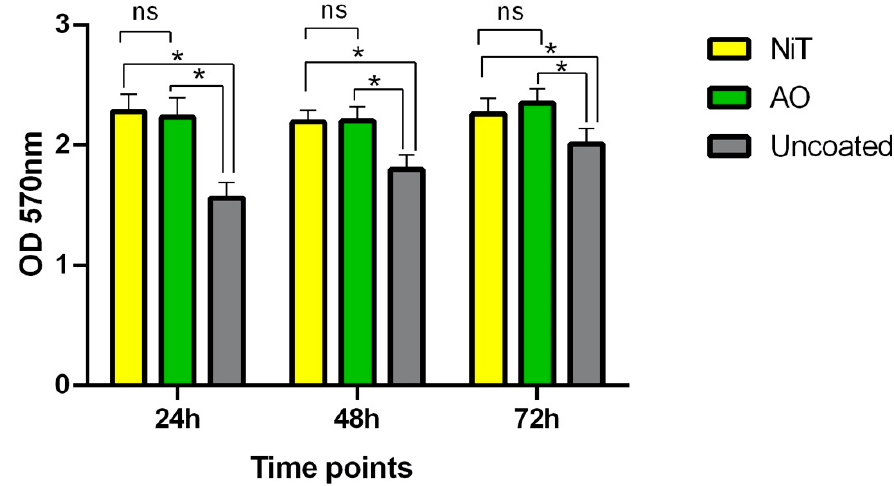
Figure 1. The methyl thiazolyl tetrazolium (MTT) assay of human gingival fibroblasts (HGFs) cultured on the investigated surfaces, measured at three timepoints (24, 48, and 72 h). ns: no statistically significant difference; * p < 0.05.